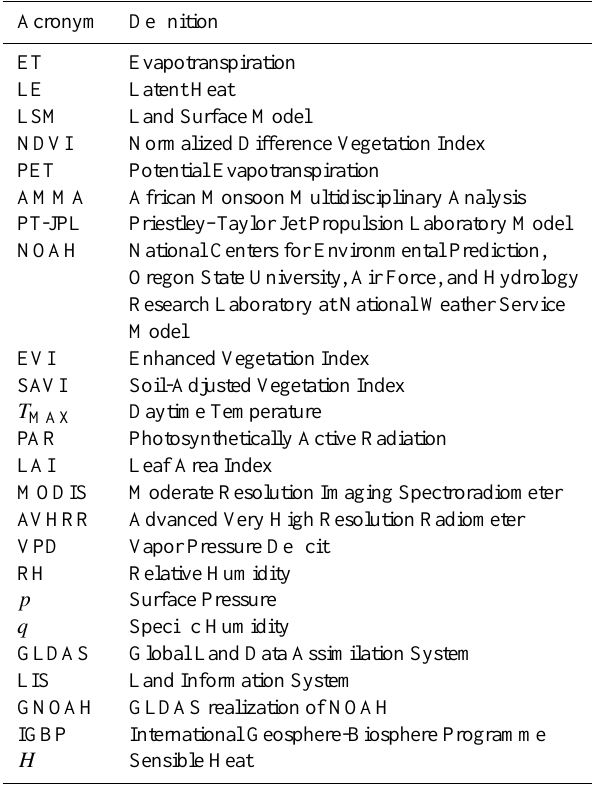
Table 1. Acronyms and their definitions in order of